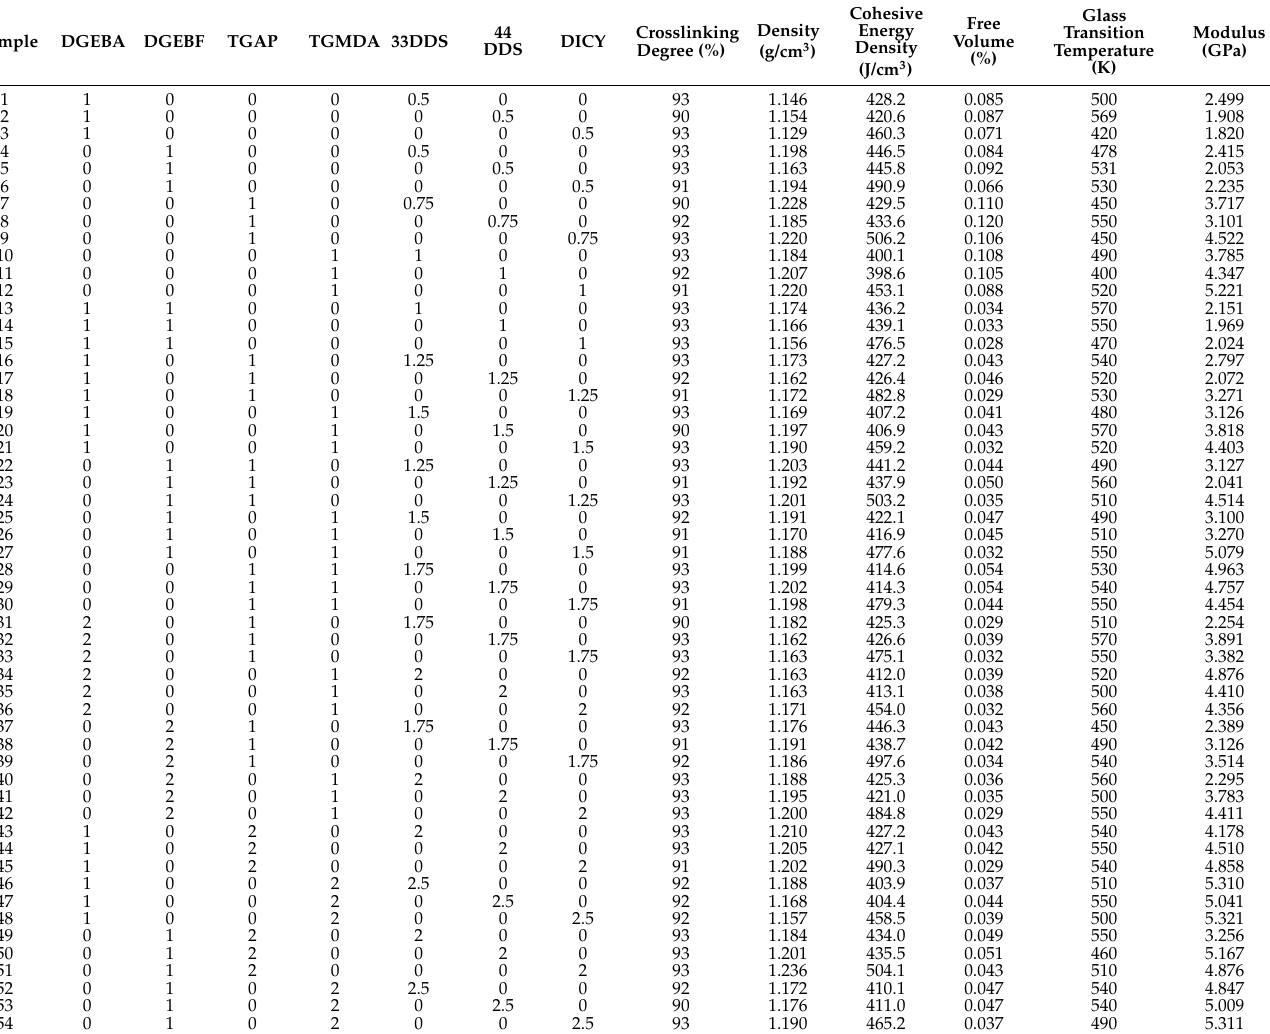
Table 1. Dataset from MD simulations for machine